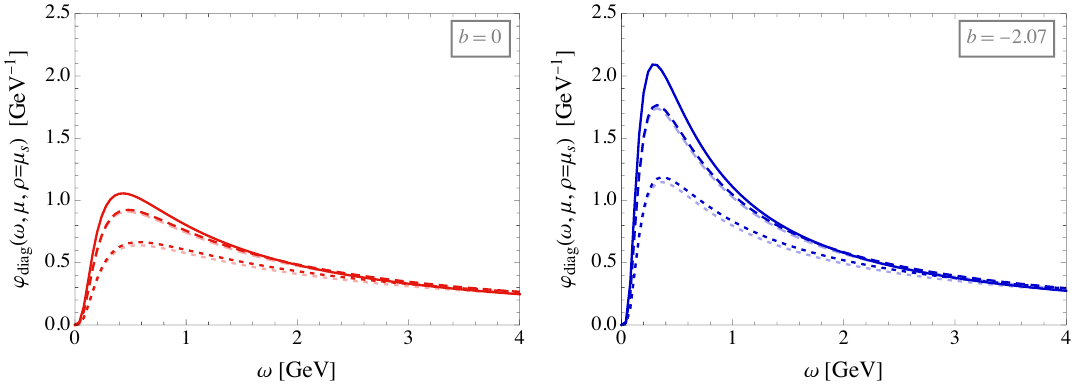
Figure 7 . Scale evolution of the model functions for the LCDA in the diagonal space with ω 0 = 482 MeV and b = 0 (left), b = − 2 . 07 (right). The solid lines show the results at µ = µ s = 1 GeV, the dashed lines correspond to µ = 1 . 5 GeV, and the dotted lines refer to the scale of the b -quark pole mass, µ = m b = 4 . 8